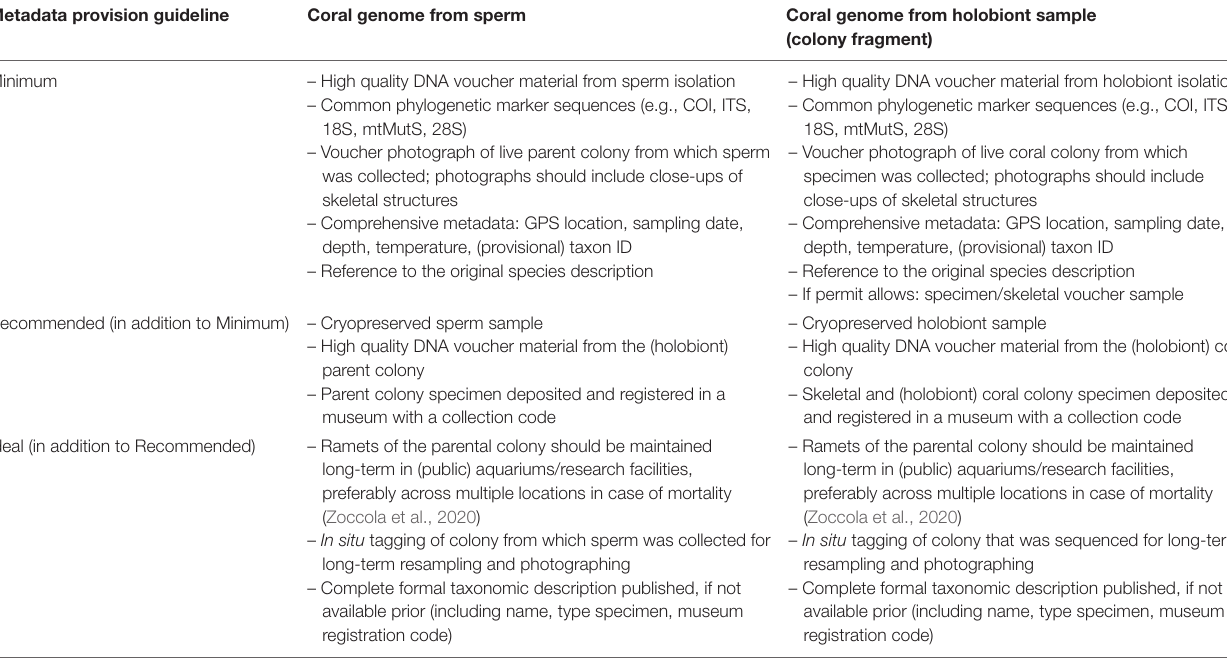
TABLE 1 | Consensus guidelines regarding associated metadata deposition for coral specimen collection targeted for genome sequencing. Metadata provision guideline